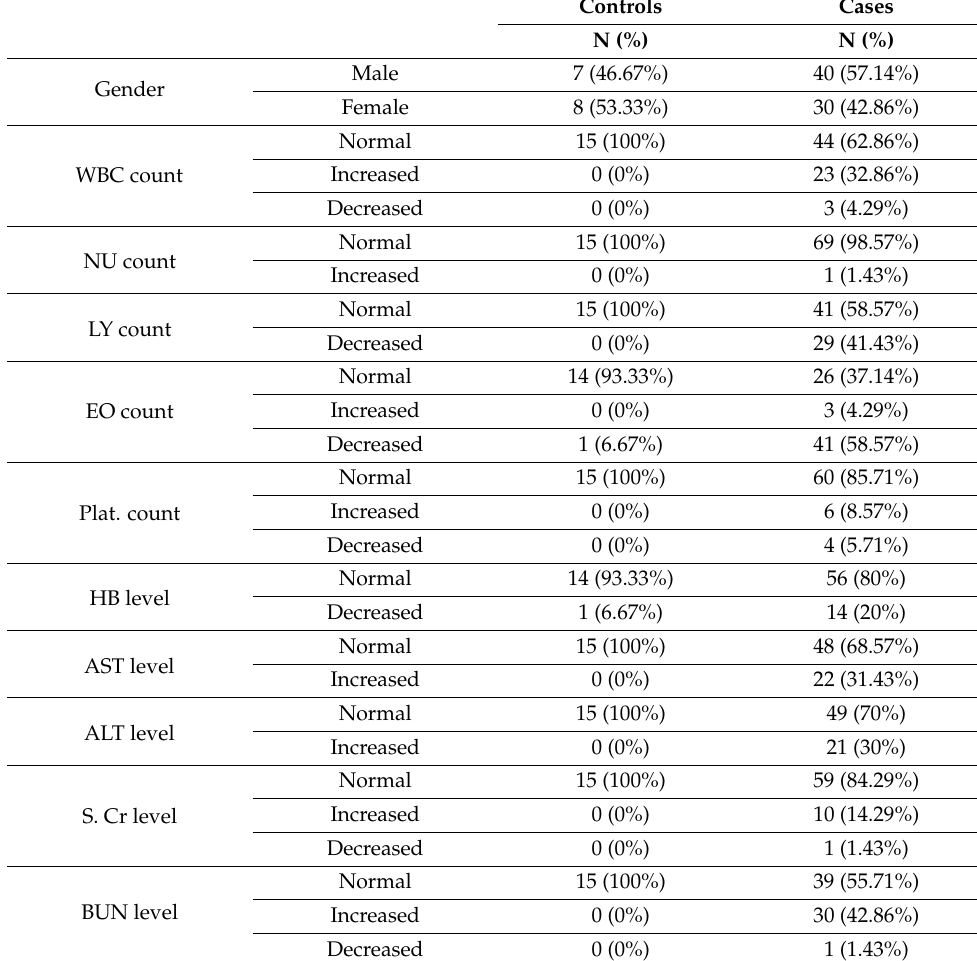
Table 3. Comparison of the gender and the laboratory data distribution between cases and controls.